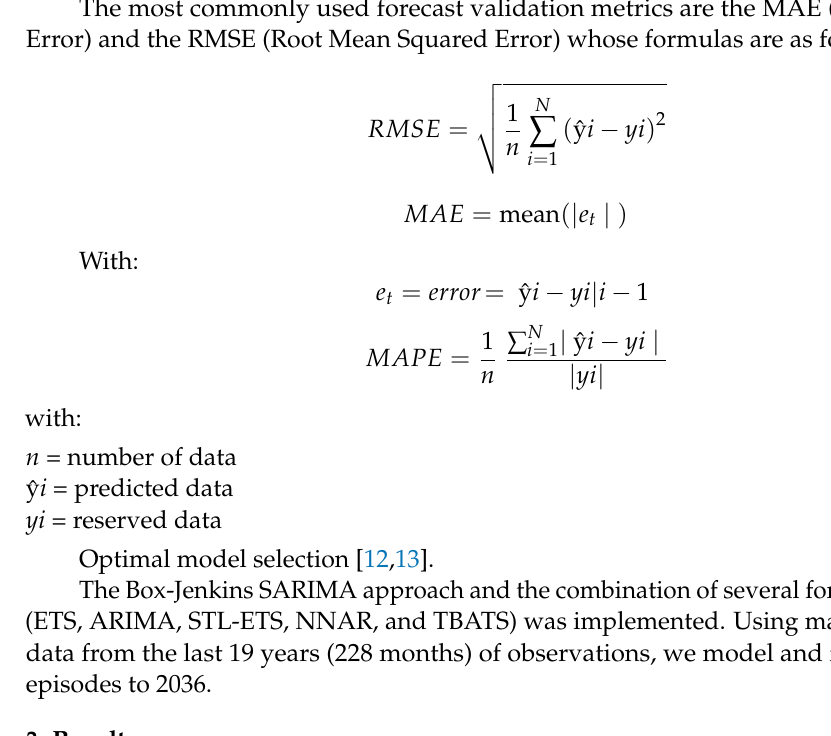
Figure 4. Training set and a test set.